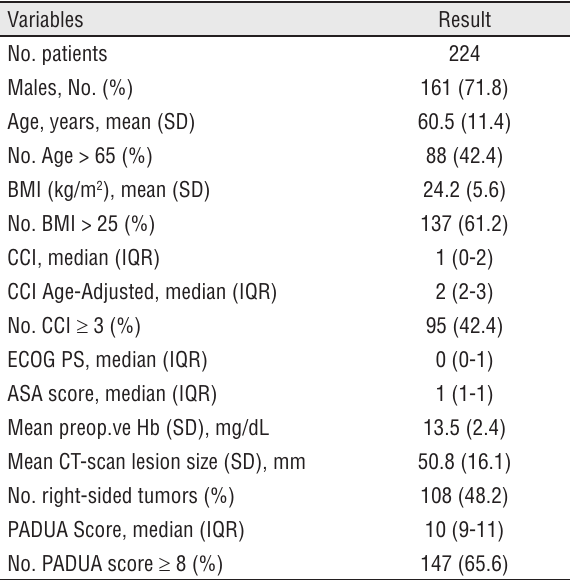
Table 1. Patients’ demographics and lesions characteristics.